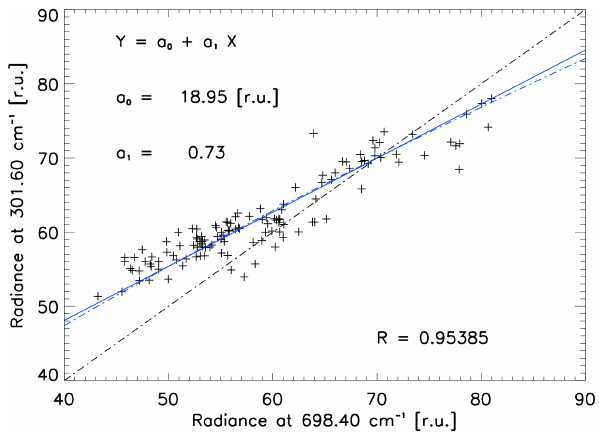
Figure 3. FIR radiances at 301.6cm − 1 against predictor MIR radi- ance at 698.4cm − 1 for all creation set spectra. The solid blue line is the linear fit of the points using Eq. (2), with regression coeffi- cients a 0 and a 1 . The linear correlation value R is indicated. For completeness, the logarithmic fit is also shown by the dashed blue line. The dashed–dotted black line represents 1 :